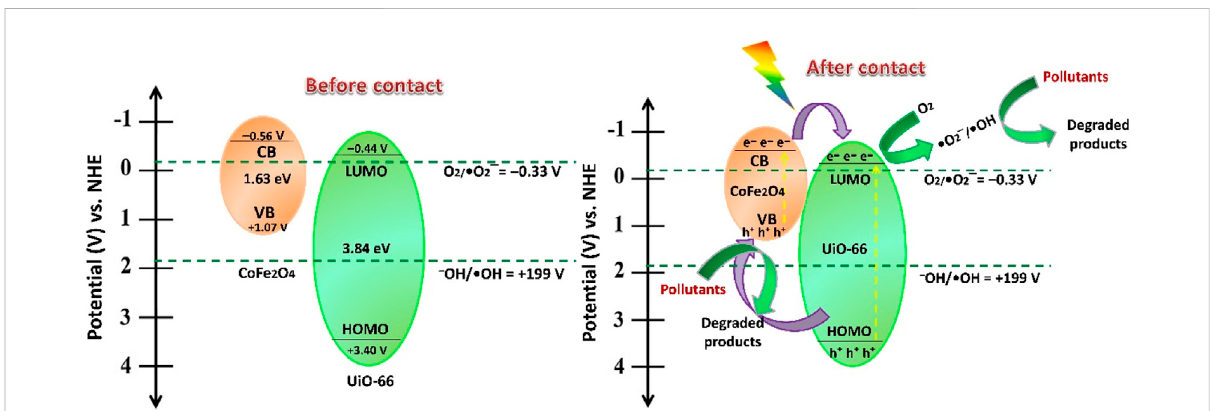
FIGURE 15 A proposed photocatalytic mechanism for dye degradation over CoFe 2 O 4 @UiO-66 heterojunction under simulative solar